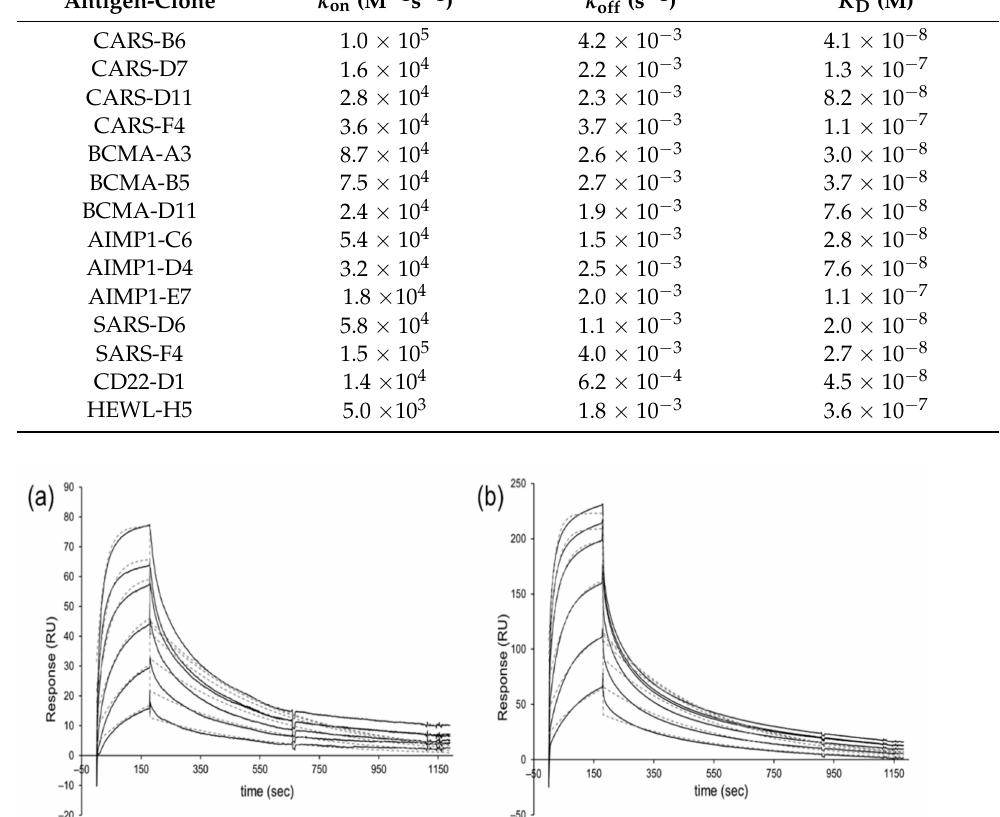
Figure 6. Representative SPR sensorgrams (solid lines) and 1:1 Langmuir binding fitting (dashed lines) of ( a ) AIMP1-D4 ( K D = 76 nM; [scFv] = 67–1070 nM) and ( b ) BCMA-B5 ( K D = 37 nM; [scFv] = 40–640 nM).